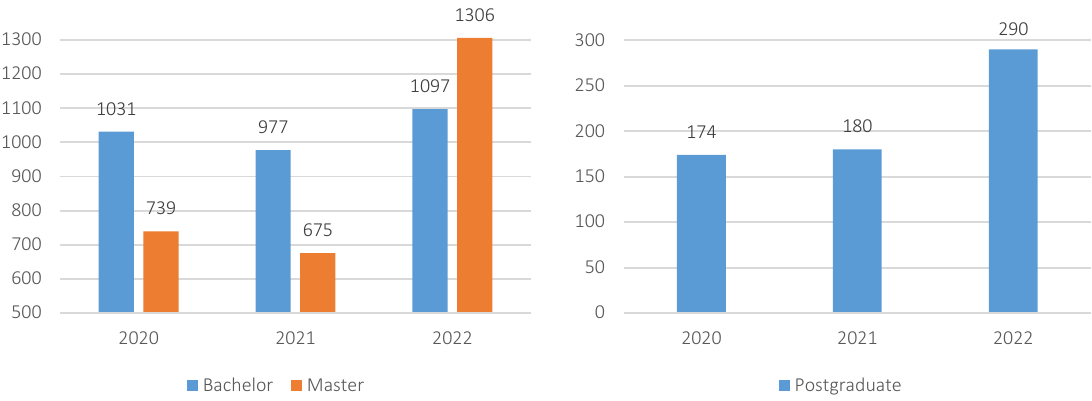
Figure A1. Admission of first year entrants to Sumy State University